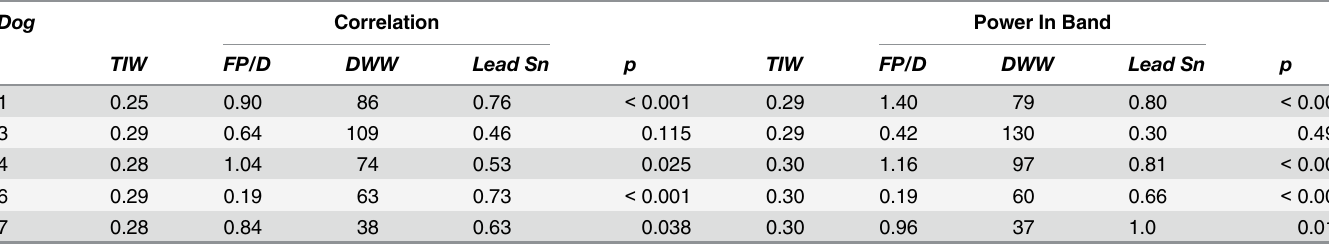
Results of SVM classi fi cation of correlation (left) and spectral power in band (right) features for the fi ve canines with adequate data and number of seizures to permit training and testing. To facilitate comparison the algorithm was tuned to approach 30% time in warning. TIW (time in warning) represents the proportion of the recording the algorithm labeled as preictal. FP/D (false positives per day) describes the mean number preictal warnings that did not produce seizures. DWW (days without warning) represents the number of 24-hour periods in which no preictal warning occurred. Lead Sn (sensitivity) represents the proportion of lead ( > 4 hour separation) seizures successfully predicted by the algorithm. The p-value was calculated using the formulation in [13].